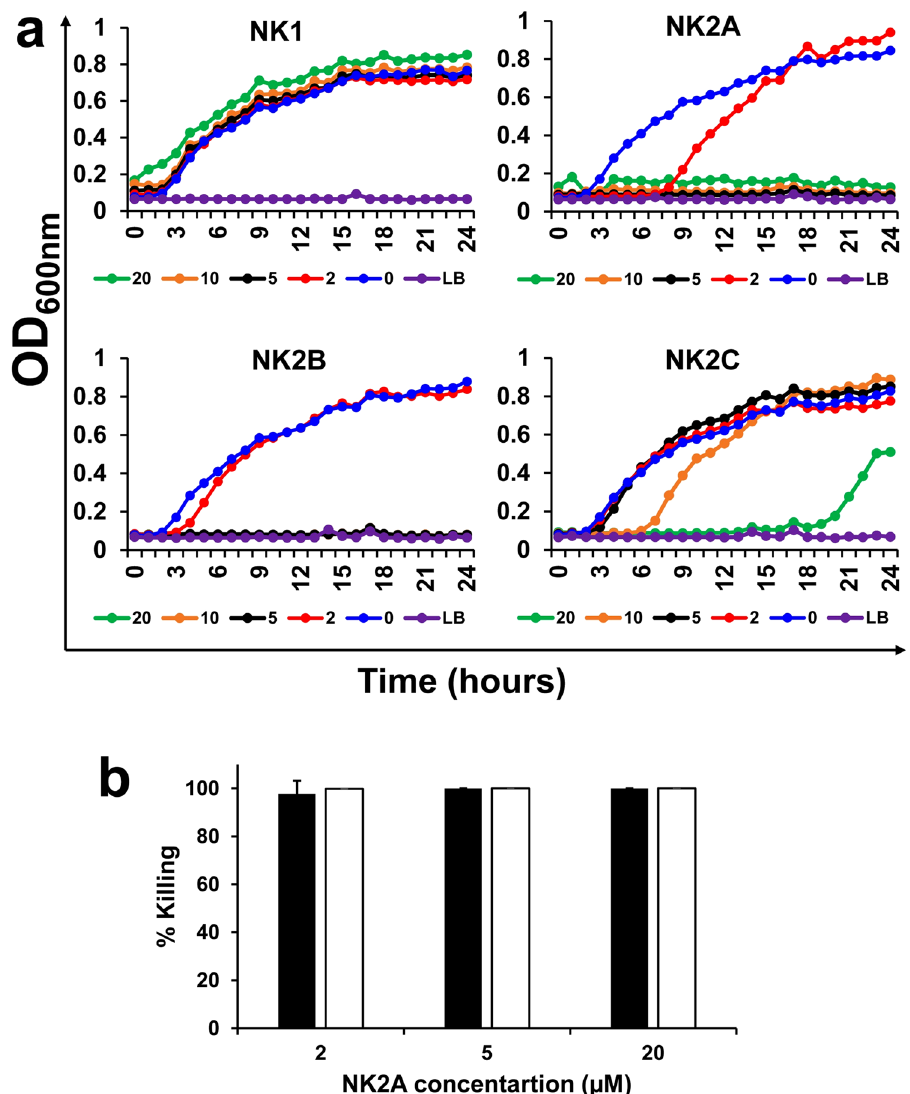
Figure 1. Antimicrobial activity of bovine NK-lysin-derived peptides against MDR Salmonella . ( a ) An MDR Salmonella outbreak isolate SX238 was incubated with different concentrations of NK-lysin peptides (0, 2, 5, 10 and 20 µM; LB = Luria–Bertani (Lennox broth)), and optical density readings at 600 nm (OD 600nm ) were recorded using an automated growth curve reader. One representative growth graph out of at least three independent experiments is shown. ( b ) Different concentrations of NK2A were incubated with Salmonella isolate SX238 at 37 °C for 3 h in PBS (filled bars) or in LB broth (open bars), serially diluted and plated on XLT plates. Following overnight incubation, bacterial colonies were enumerated. Data represent mean percentages of (bacterial) killing ± SD from three independent experiments. P = 1.0000 as determined by ANOVA test using GLM procedure from SAS software, Version 9.4 of the SAS System for